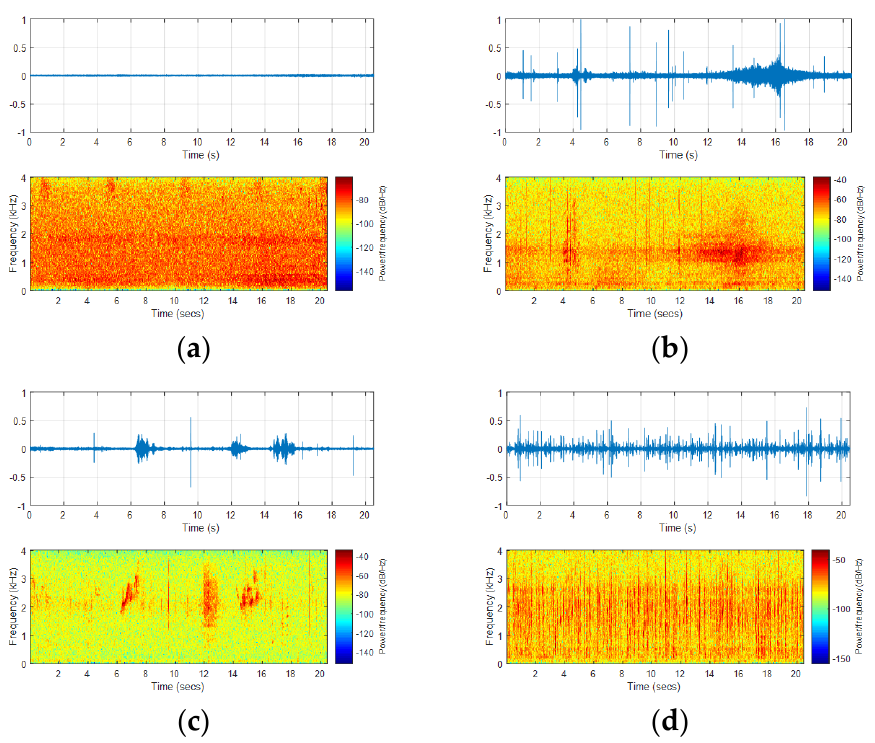
Figure 6. Transmitted vibrational recordings from different trees under different circumstances. ( a ) Healthy young pine in a calm day. No train of impulses, ( b ) infested tree in alley near heavy traffic. Impulse trains in the presence of human vocalizations and traffic, ( c ) an infested tree in the presence of strong birds’ vocalizations, ( d ) healthy, young, apricot tree. Recording taken during a heavy shower. All impulses are due to rain, and shaking branches/leaves due to strong wind. In Figure 7, we compare the spectral profiles of long duration recordings taken from parts of an infested and a non-infested trunk carried in a silent room of a laboratory (i.e., there was no background noise). A different borer in a different tree could create acoustic emissions with a different spectral profile; nevertheless, it would not be flat like the non- infested one. The power spectral density (PSD) one-sided estimate, of each recording sampled at 8 kHz is found using Welch’s overlapped segment averaging estimator. To elaborate further, the signal is divided into sections of length of 512 samples. The modified periodograms are computed using a Hamming window of the same length as the window. The overlapping in windowing equals to 50% of the window